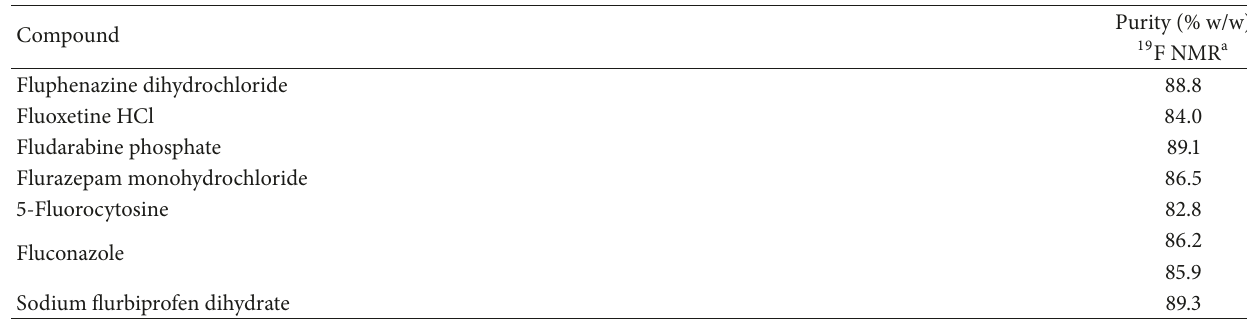
Table 4: Analytical results for buffer-soluble